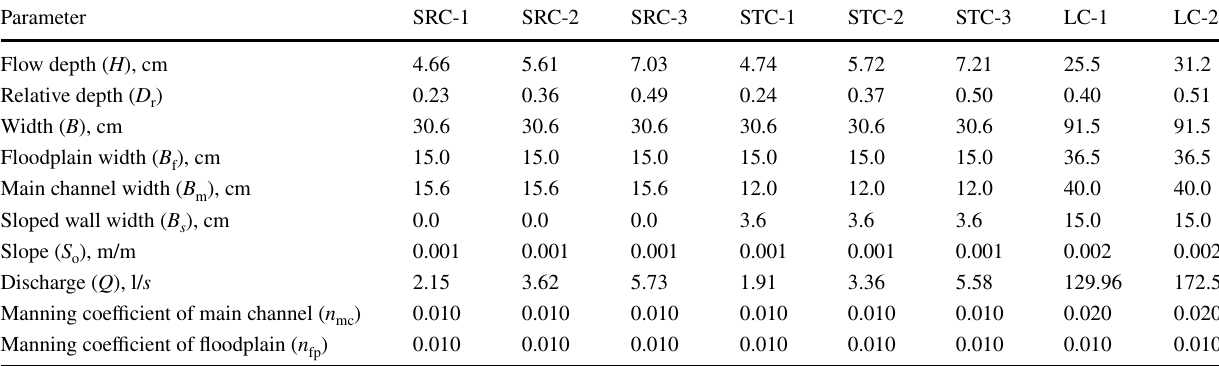
Floodplain width ( B f ),